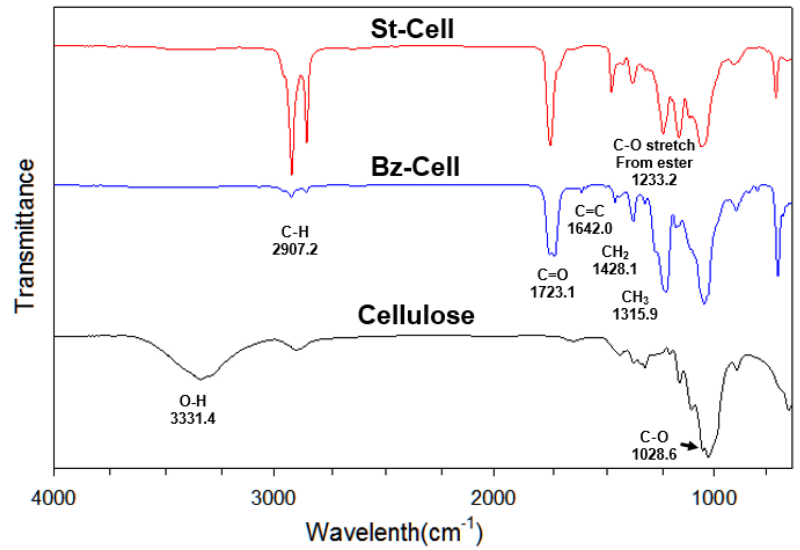
Figure 3. Fourier transform infrared (FT-IR) spectra of cellulose (black); Bz–Cell (blue); and St–Cell (red). Table 1. FT-IR absorption bands for cellulose, Bz–Cell, and St–Cell.